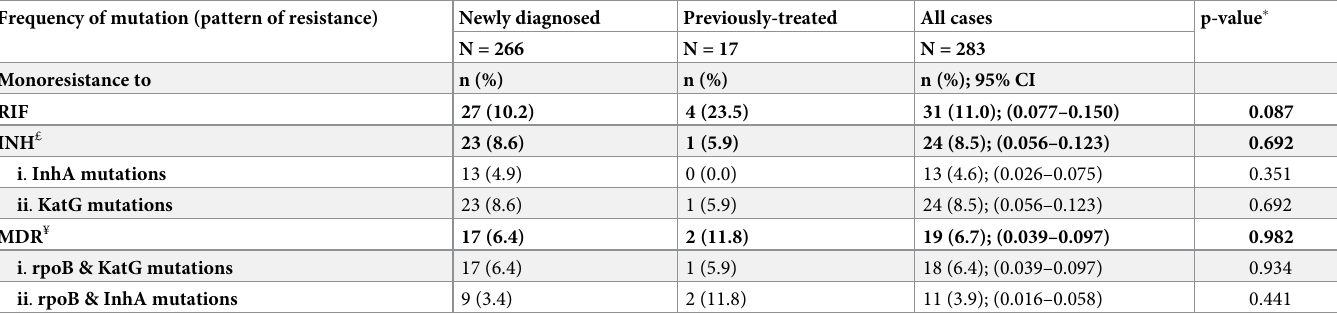
Table 2. Frequency of rpoB, KatG and InhA mutations in Mycobacterium tuberculosis causing PTB in southwestern Uganda; May 2018 and April 2019. Frequency of mutation (pattern of